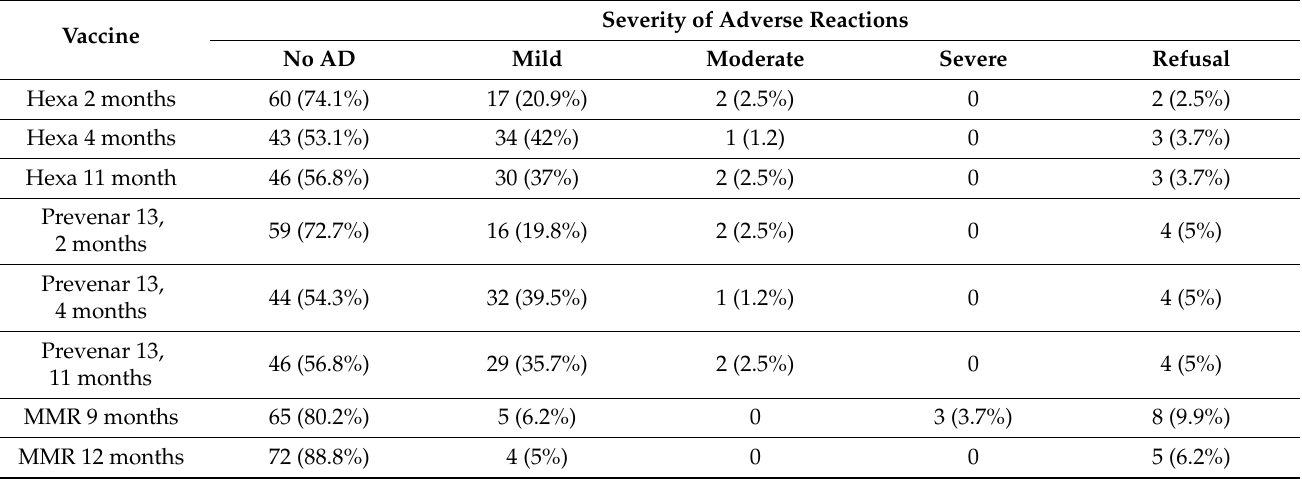
Table 2. Severity of adverse reactions induced by vaccine